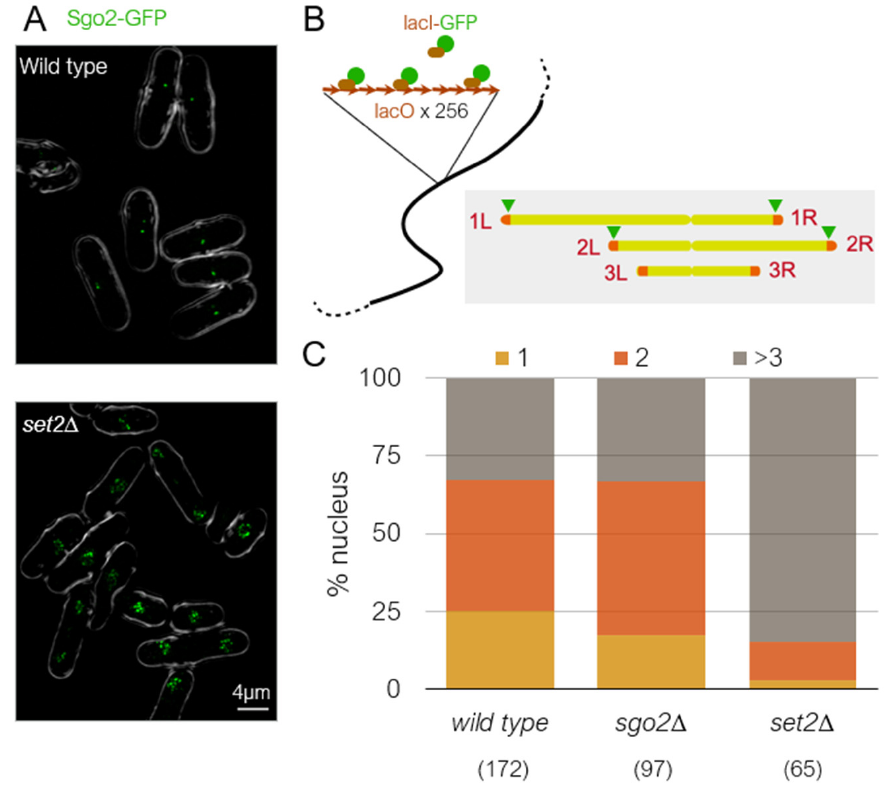
Figure 5. Factors regulating subtelomeric clustering and knob formation. ( A ) Sgo2-GFP localization in wild-type and set2 ∆ cells. Sgo2-GFP localizes to the subtelomeric regions of chromosomes 1 and 2 in interphase. The Sgo2-GFP foci cluster to make a single dot in wild-type cells but are dispersed in set2 ∆ cells. ( B ) The LacO–LacI system to visualize chromosomal loci. The lacO array was inserted near the four boundaries between euchromatin and ST chromatin of chromosomes 1 and 2 (AC1, AC26, CII-L, and CII-R in Matsuda et al., 2015 [65]) and visualized by lacI-GFP. ( C ) Number of apparent lacI-GFP dots in wild-type and mutant nuclei. While many nuclei contained only 1 or 2 dots in wild-type and sgo2 ∆ , the majority of nuclei contained more than 3 dots in set2 ∆ nuclei, indicating that subtelomeric regions are not clustered in set2 ∆ . Numbers in parentheses indicate number of cells examined.